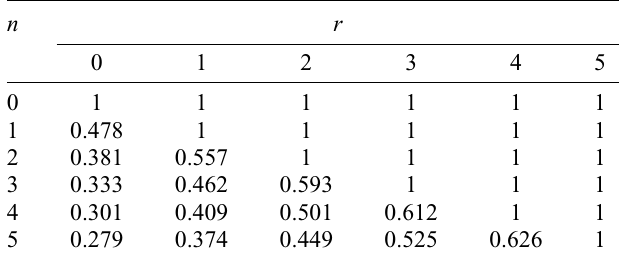
TABLE IV. Maximum achievable fidelities with Fock states | n (cid:3) using states with stellar rank less or equal to r , for n , r ∈ { 0, . . . , 5 } (rounded to the upper thousandth).